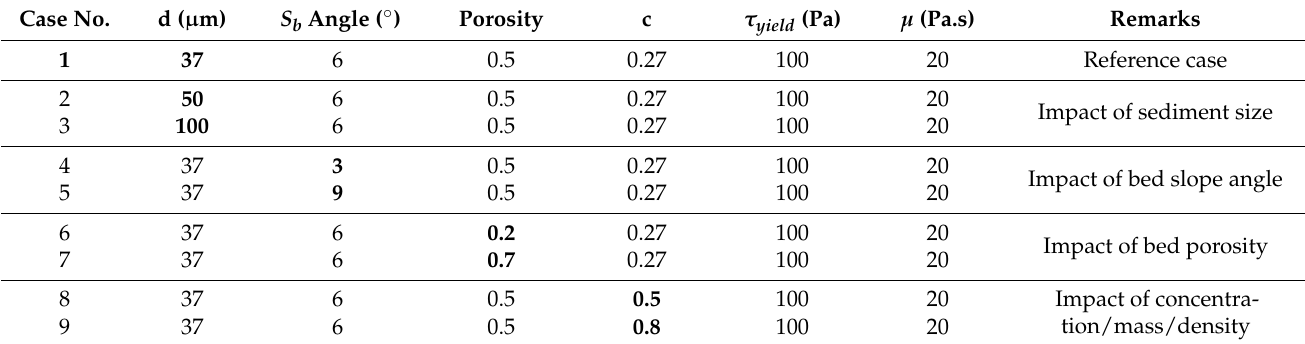
Table 2. Summary of sensitivity analysis